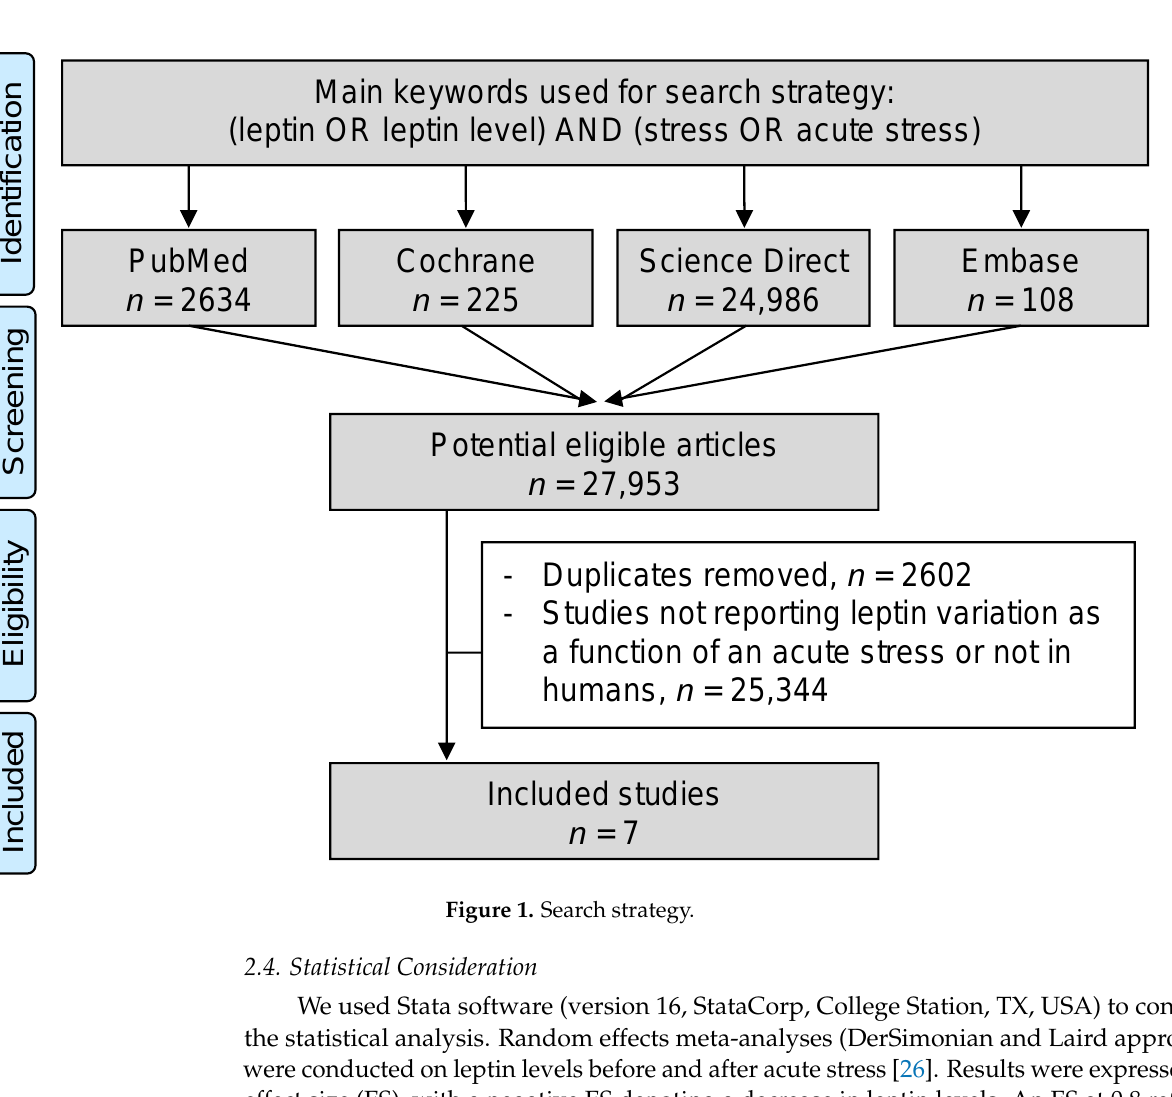
Figure 1. Search strategy.